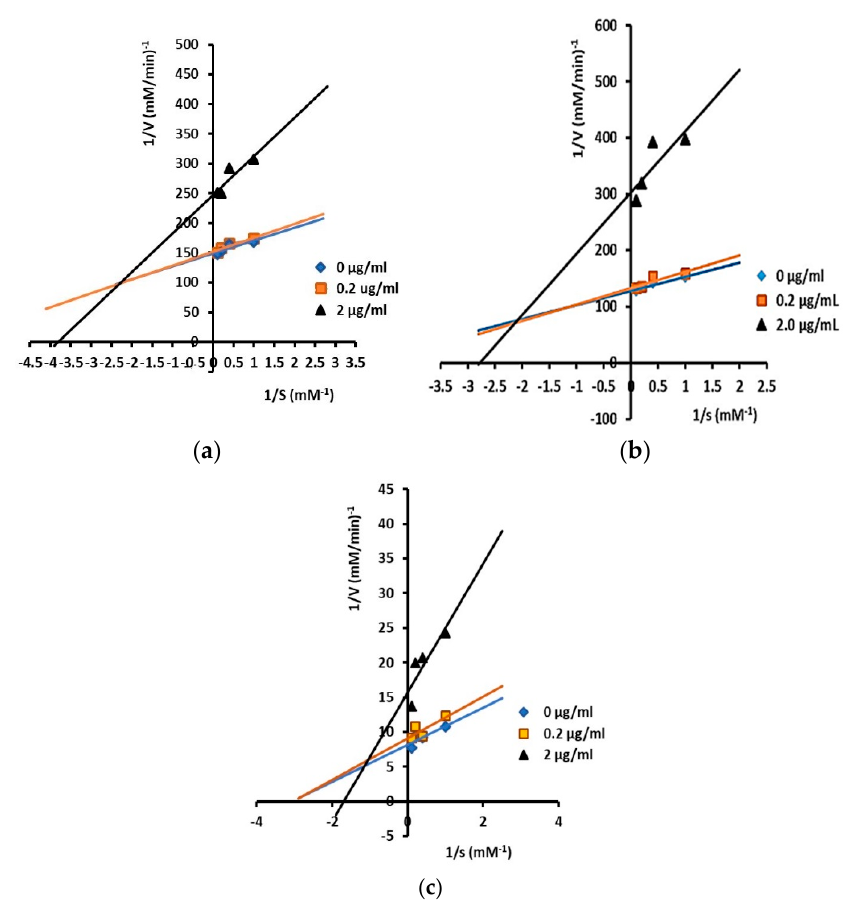
Figure 3. Lineweaver–Burk plots for kinetic analysis of α -glucosidase inhibition by isolated triterpenes: ( a ) compound 3 ; ( b ) compound 4 ; and ( c ) compound 5 at varying concentrations (showing mixed inhibition). The concentration of p-NPG was measured as a substrate in the absence or presence of inhibitors at different concentrations against α -glucosidase. All values are means ± standard errors ( n = 3).